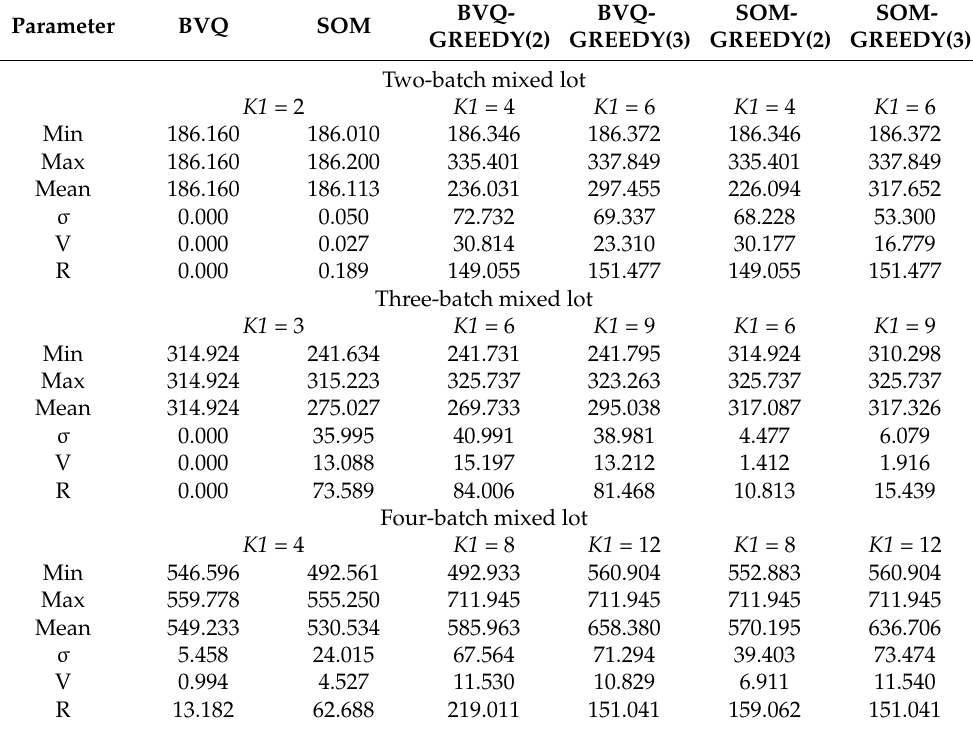
Table A8. Objective function value summarized after 30 attempts (squared Euclidean distance, initialization by